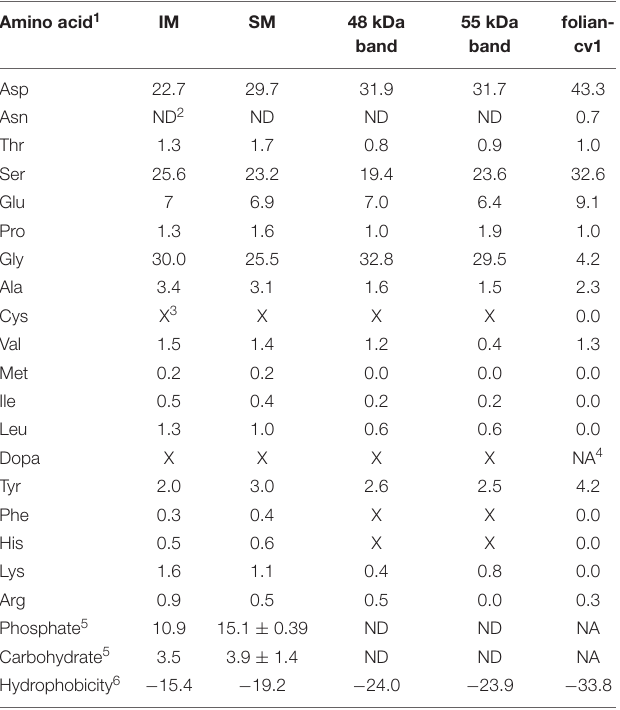
TABLE 1 | Amino acid compositions of shell matrix fractions compared with the deduced amino acid composition for folian-cv1. Amino acid 1 IM SM 48 kDa